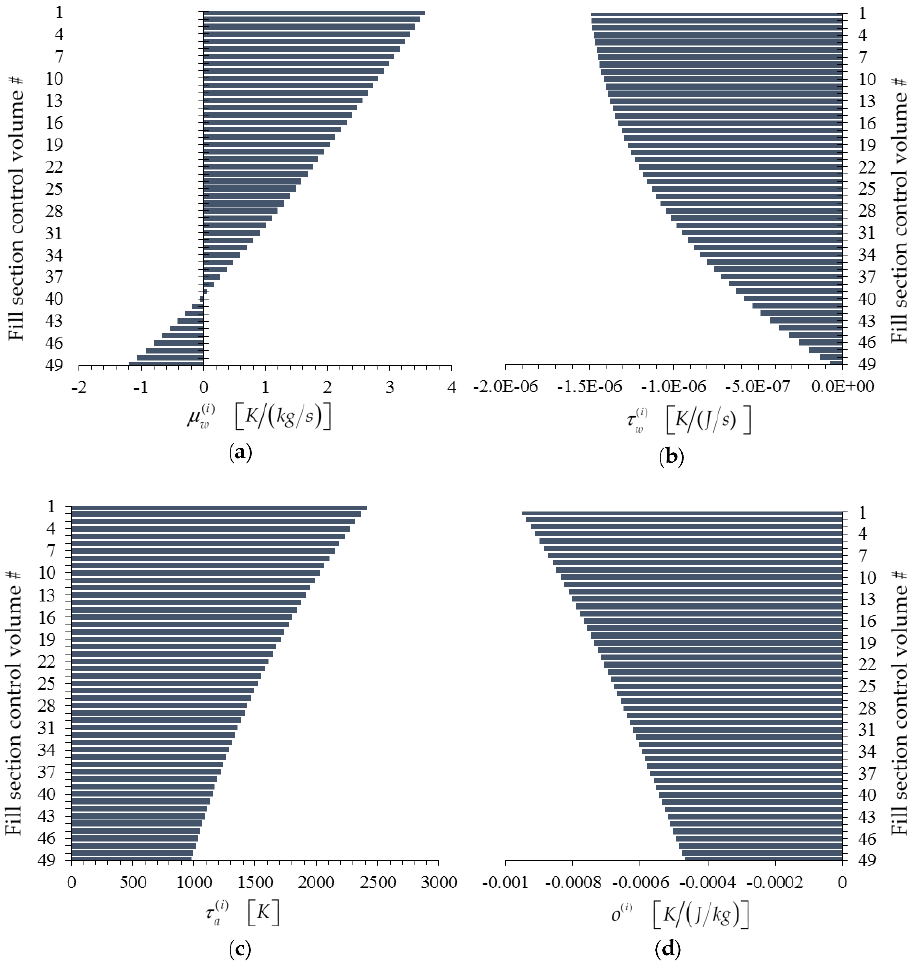
Figure 8. Bar plots of adjoint functions for the response (1) R (cid:44) T cooling tower’s fill section: ( a ) µ w (cid:44)